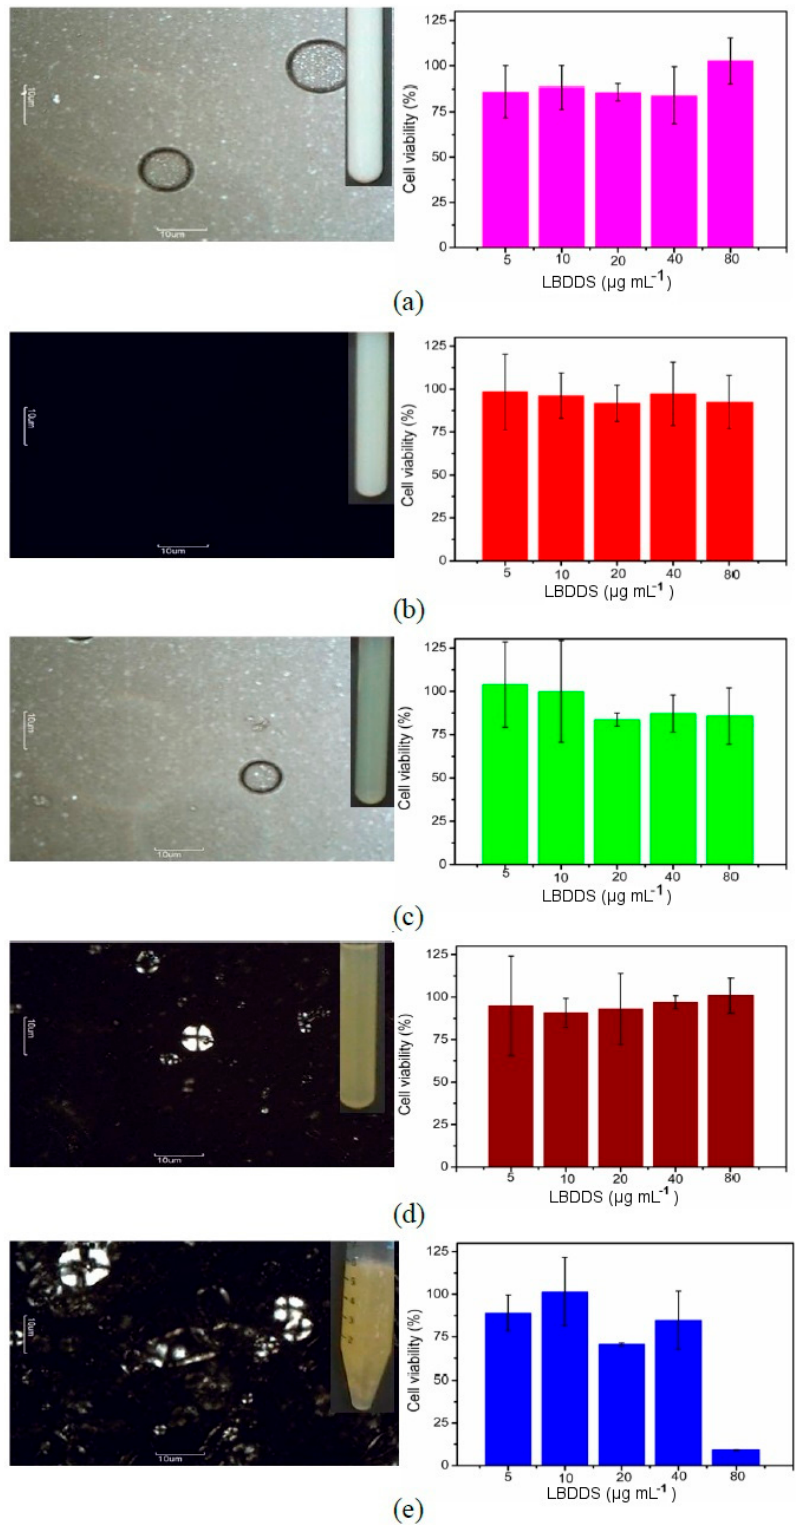
Figure 4. Isotropic/anisotropic behavior assessed by CPLM ( left , magnification 400×) and the respective cell viability assays for the different LBDDS (SOR of ( a ) 0.5, ( b ) 1.0, ( c ) 1.5, ( d ) 2.0 and ( e ) 2.5) against Vero cells after 12 h at 37 °C ( right ). Note: data of the relative cell viability are expressed as the mean ± SD ( n = 3).